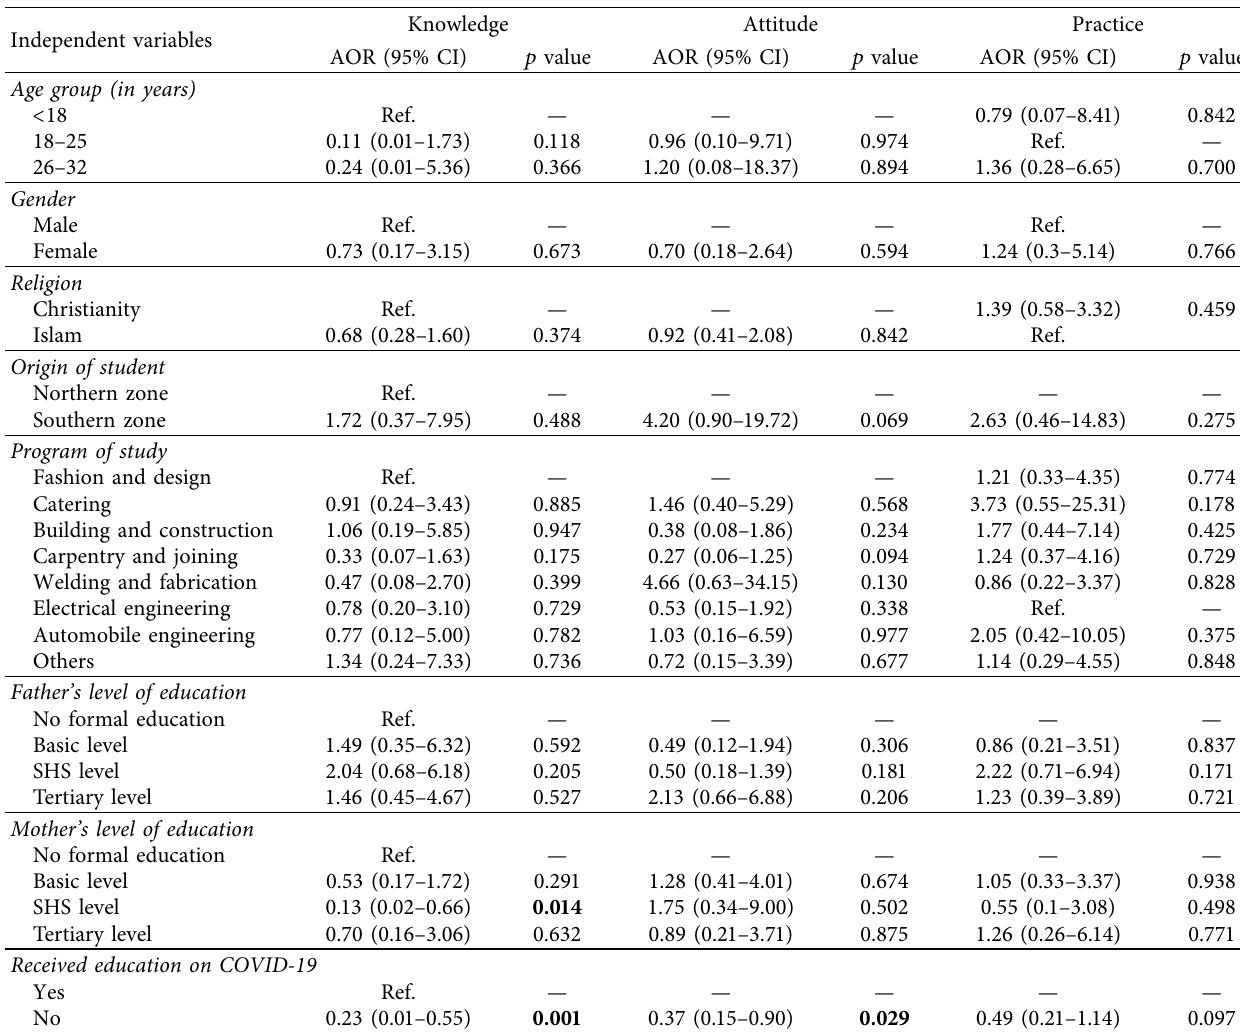
Table 4: Factors associated with knowledge, attitudes, and practices among students at Tamale Technical